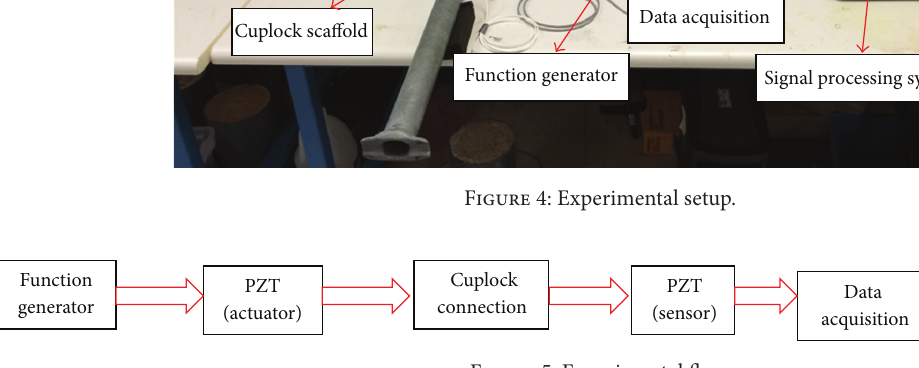
Figure 5: Experimental flow.